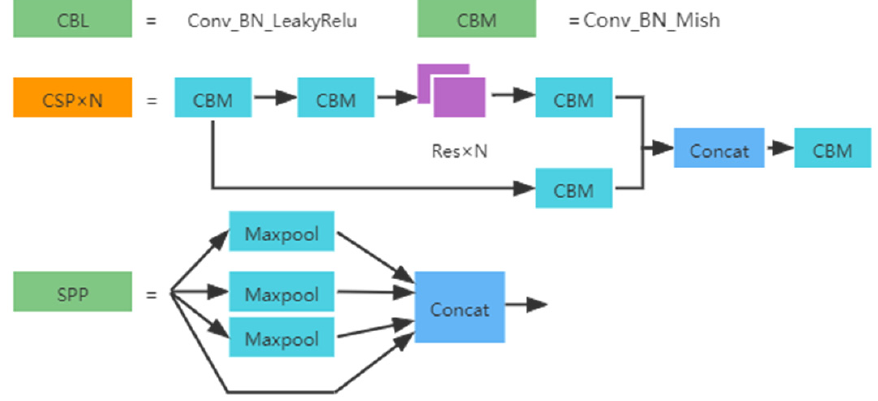
Figure 2. Module structure diagram.